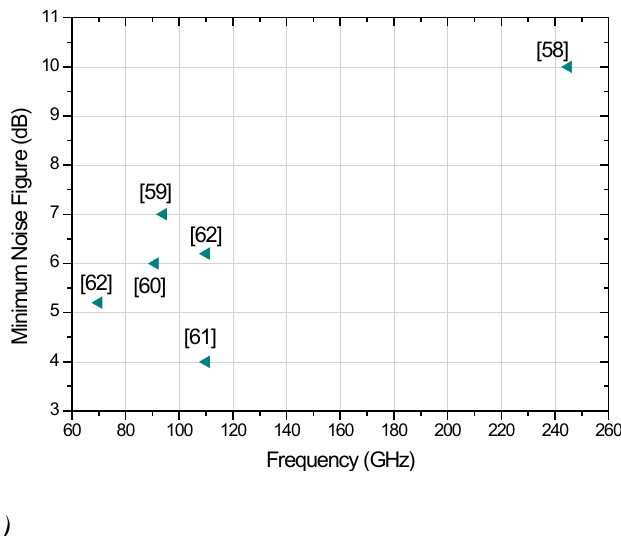
Figure 4. Measured minimum noise figure of the recent published MMW SiGe LNAs. Data taken from